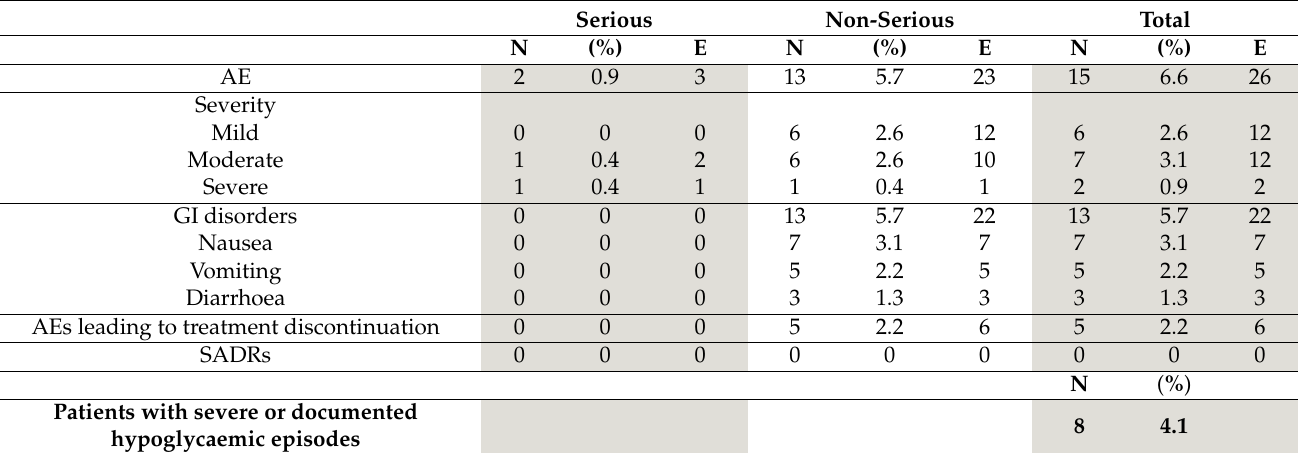
Table 3. AEs and severe or documented hypoglycaemic episodes in patients receiving semaglutide